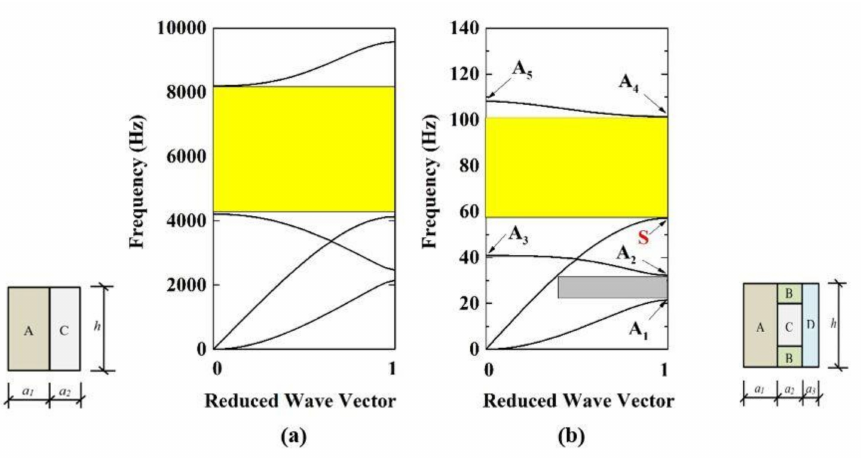
Figure 5. Dispersion curve. ( a ) The two-element PC plate; ( b ) The proposed PC